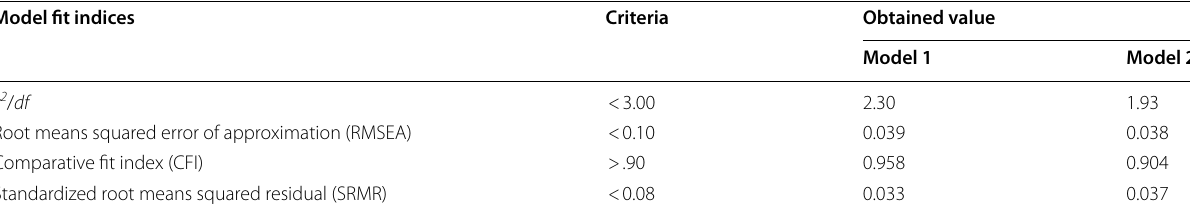
Table 4 Descriptive measures of the model fit Model fit